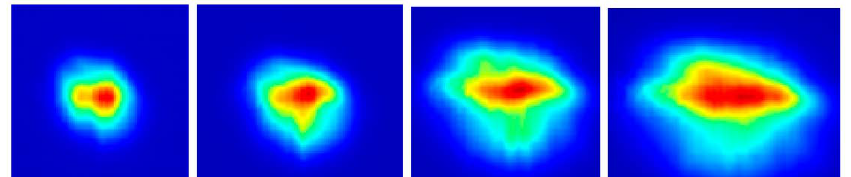
Figure 14. Laser far-field distortion with the increase in pump fluence under pumping with one- dimensional MLA. W increases from left to right of the image by 2.9 times. Reprinted with permission from ref. [19]. Copyright 2019 © SPIE.